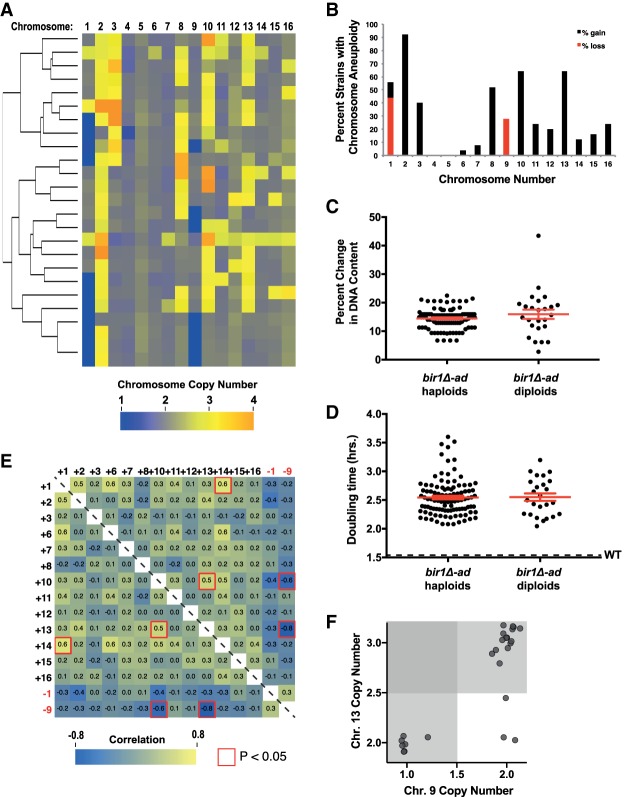
Ploidy greatly affects chromosome copy number correlations. (A) Heat map visualization of chromosome copy number values for diploid bir1Δ-ad strains clustered by similarity. Each of the 25 diploid bir1Δ-ad strains is represented as a row. (B) Frequency of the aneuploid chromosomes in the diploid bir1Δ-ad strains from binarization of the data shown in A. (C) Percentage change in overall DNA content as measured by taking the binarized copy number values of each chromosome, subtracting the basal ploidy 2, multiplying each by the fraction of the genome represented by that chromosome, and then summing the absolute values for all of the chromosomes. There was no significant difference between the two groups. P = 0.16. (D) Cell doubling times for the haploid and diploid bir1Δ-ad strains. There was no significant difference between the two groups. P = 0.91. (E) Heat map of the correlations between chromosome copy numbers for the 25 diploid bir1Δ-ad strains. Only correlations between chromosomes where aneuploidy was observed are shown. Each cell of the matrix contains the correlation coefficient between the two chromosomes written in the rows and columns. The red highlighted border represents correlations that had a P < 0.05 in the hypergeometric test. (F) Scatter plot of specific chromosome copy numbers of 25 diploid bir1Δ-ad strains demonstrating a negative correlation between monosomy of chromosome 9 and trisomy of chromosome 13. Copy number data are from read frequencies as in E. The darker-gray region contains strains that are aneuploid for both of the plotted chromosomes. Mean values and the standard error of each group are indicated in red with error bars.